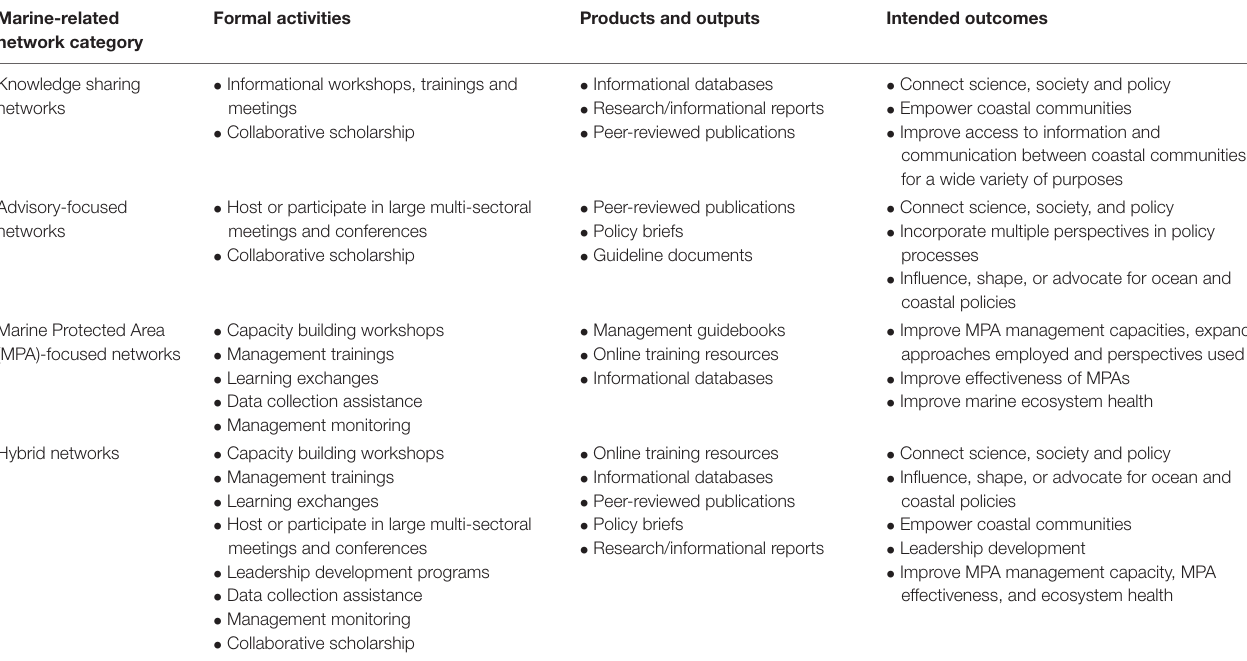
TABLE 2 | Four generalized marine-related learning network categories and their associated activities, outputs, and intended